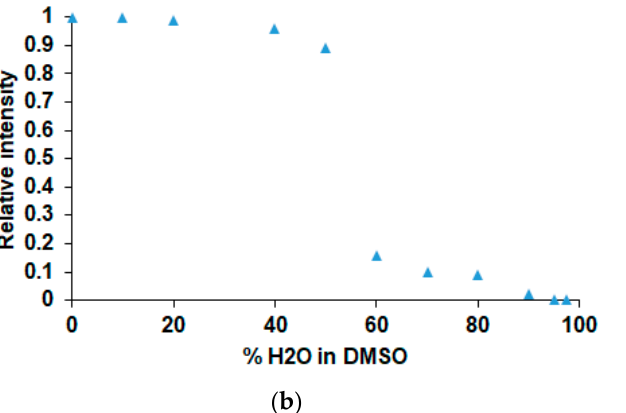
Figure 3. ( a ). Visible absorption spectra of BODIPY 1 (1.0 × 10 − 5 M) in a DMSO–H 2 O binary solution at different ratios. ( b ). The variation of the fluorescence relative intensity (IF/IF0) of BODIPY 1 as a function of % H 2 O in DMSO. The concentration of the dye was kept constant 1.0 × 10 − 5 M.